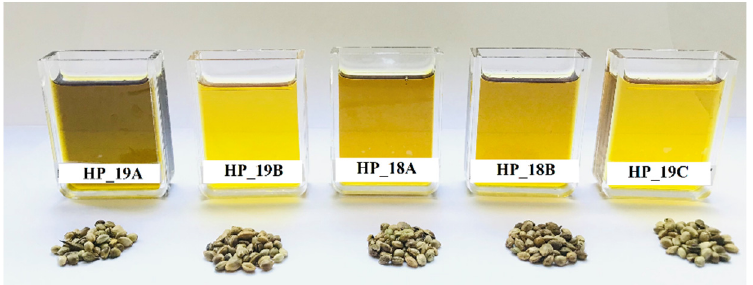
Figure 1. Hemp seeds and cold ‐ pressed hemp seed oils. Group 1 oils (HL_18A, HL_18B) and group 2 oils (HL_19A, HL_19B,